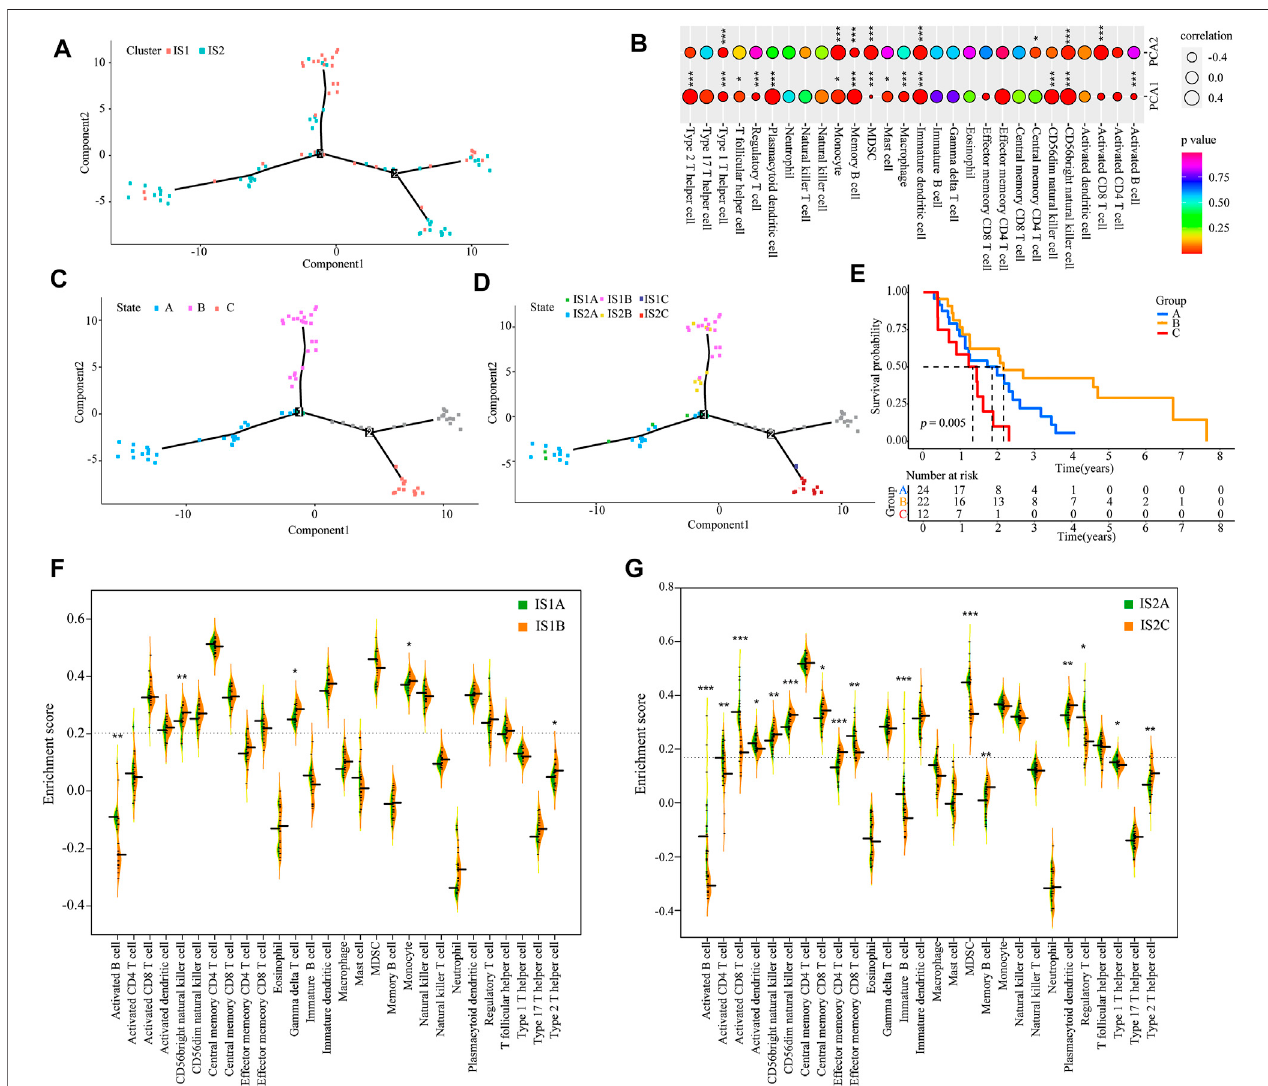
FIGURE 8 | Immune landscape of mesothelioma (A) Immune landscape of mesothelioma (B) Correlation between PCA1/2 and immune modules. The immune landscape of patients from three extremely distributed locations (C) , and their Kaplan-Meier curves (E) (D) Further strati fi cation of IS1 and IS2 based on their location on the immune landscape (F,G) The difference in the enrichment scores of immune signatures between the subsets. IS1A vs. IS1B (F) . IS2A vs. IS2B (G) (* p < 0.01, ** p < 0.001, and, *** p < 0.0001).